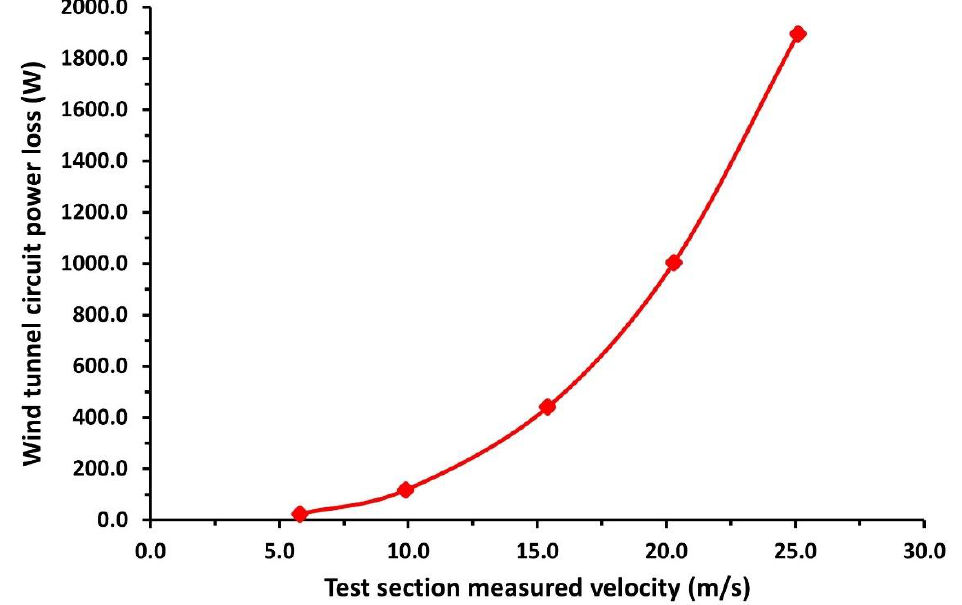
Figure 12. Wind tunnel circuit power loss versus test section measured velocity.